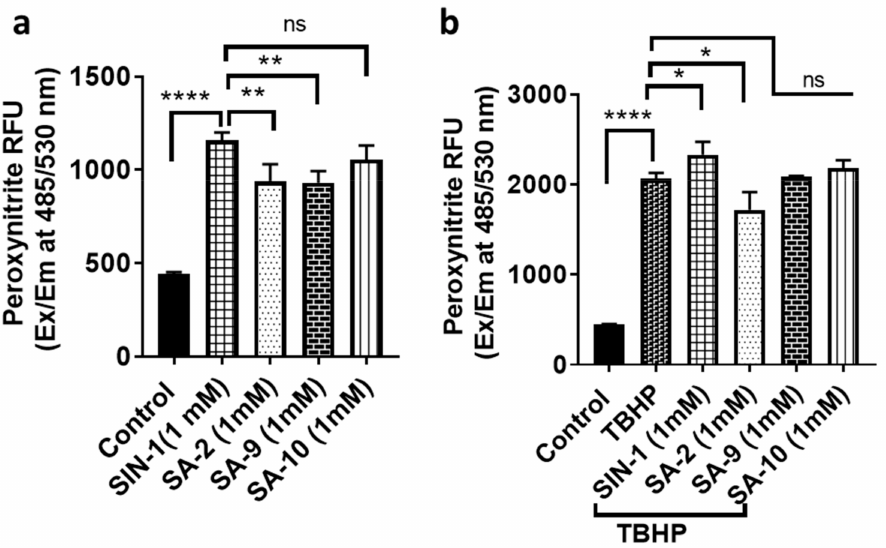
Figure 6. Quantitative measurement of ONOO − radical generation in NTM-5 cells. ( a ) NTM-5 cells were labelled with peroxynitrite green sensor followed by treatment with 1 mM of SIN-1, SA-2 , SA-9 , and SA-10 . Changes in green fluorescence signal corresponded to level of ONOO − radicals as measured at Ex/Em of 485/530 nm. ( b ) NTM-5 cells labelled with peroxynitrite green sensor followed by treatment with TBHP (350 µ M) and 1 mM of SIN-1, SA-2, SA-9 , and SA-10 .. Changes in green fluorescence signal corresponded to the level of ONOO − radicals as measured at Ex/Em of 485/530 nm. n = 3, * p < 0.05, ** p < 0.001, **** p < 0.0001. One-way ANOVA, Graph Pad